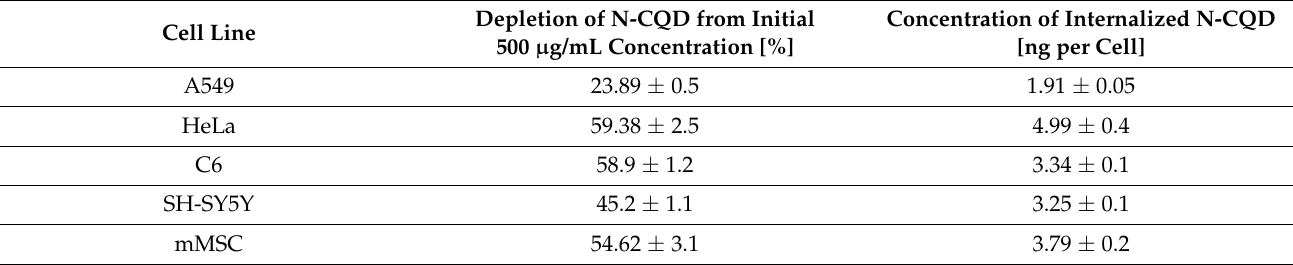
Table 1. Concentration of N-CQD internalized by different cells within 72 h—calculations are based on the depletion of nanomaterial from culture media. Cell